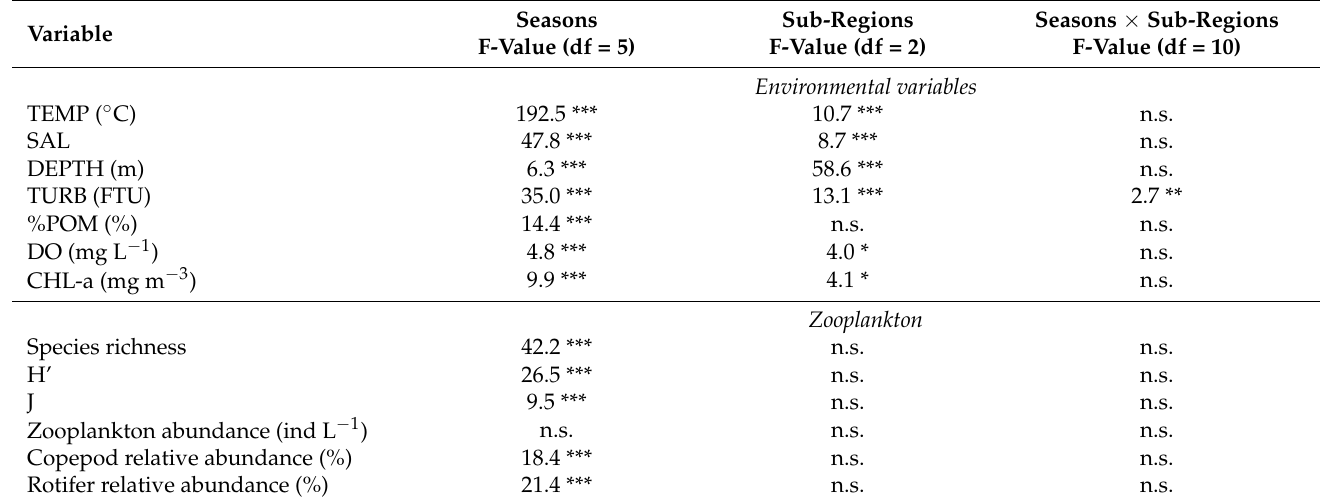
Table 3. Significant F-values ( p < 0.05) derived from two-way ANOVA on the influence of seasons (bi- monthly campaigns), sub-regions and interaction between seasons and sub-regions on